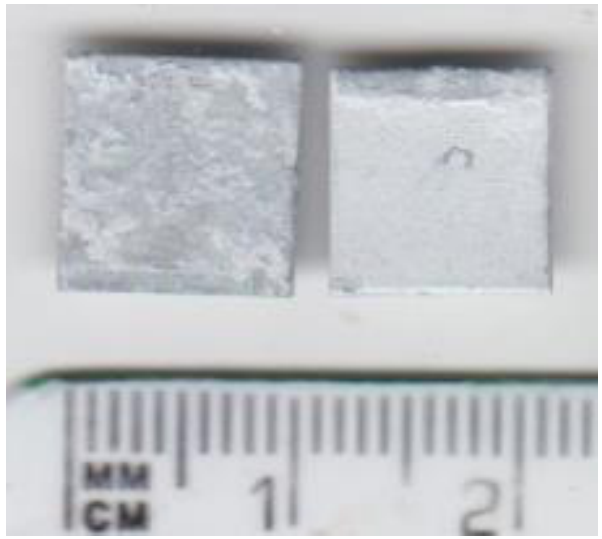
Figure 4. Image taken of hydrophobic samples coated with formulation 1 ( left ) and 3 ( right ) without and with 2% wt. 1 M NaOH addition, respectively.